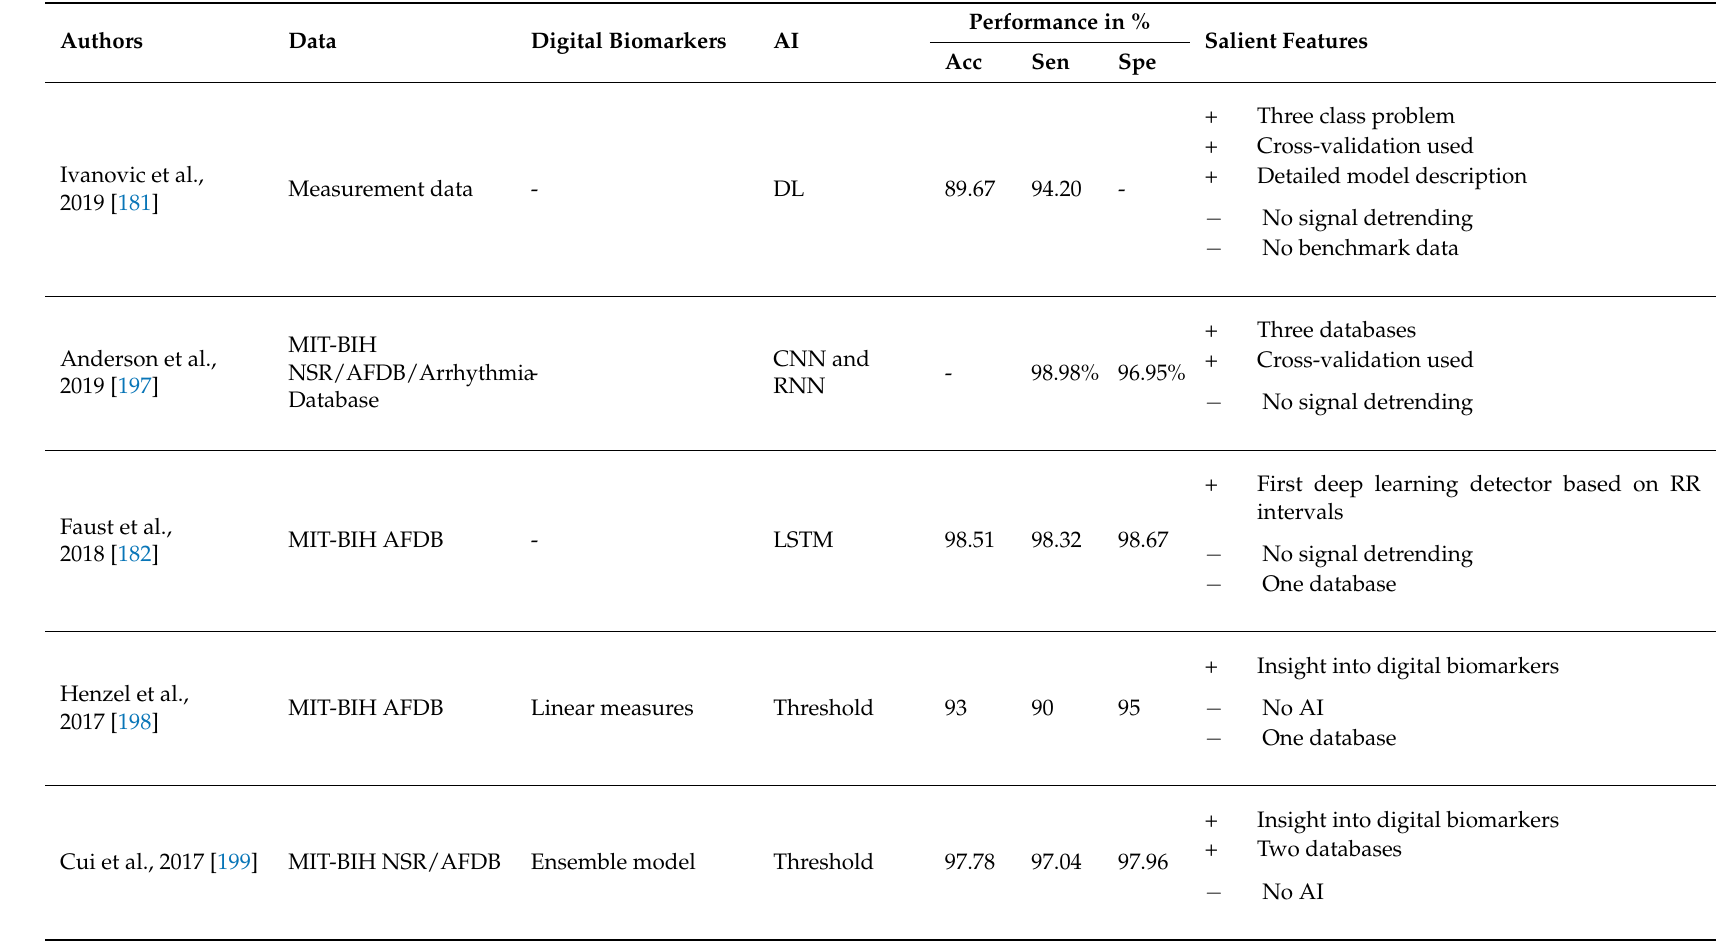
Table 2. A summary of automated AF detection in RR interval